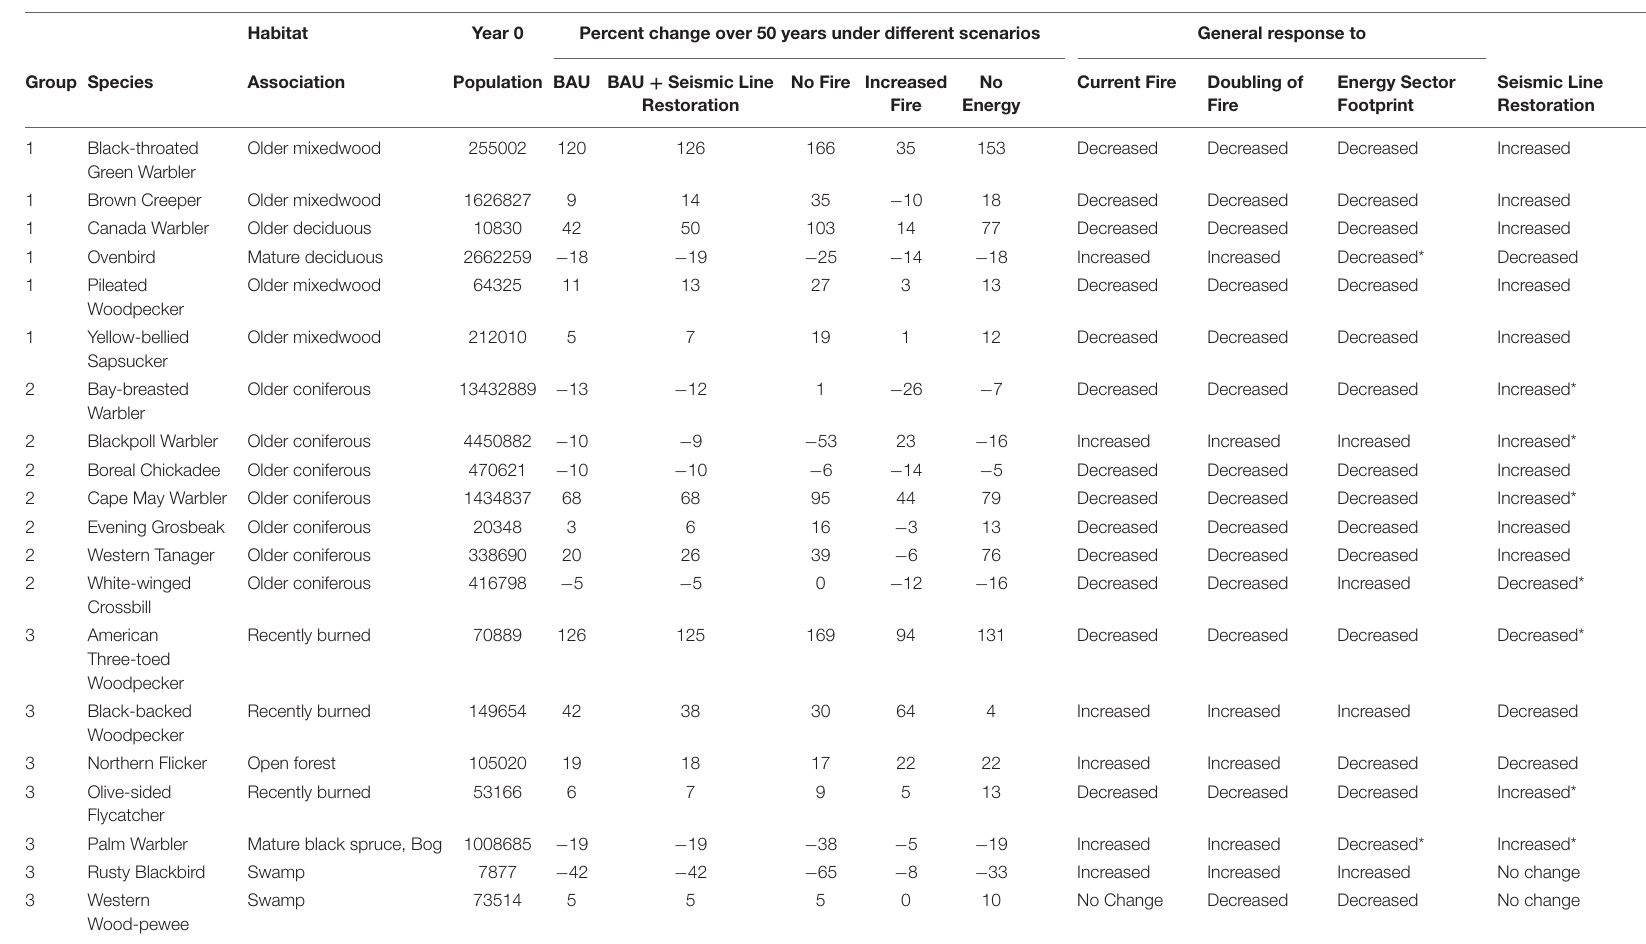
TABLE 3 | Initial population size and projected percent change in population of 20 species in the Al-Pac FMA over 50 years under 5 land use scenarios, along with projected response of each species to simulated current fire rates, doubled fire rates, energy sector development without seismic line restoration, and energy sector development with seismic line restoration. Habitat Year 0 Percent change over 50 years under different scenarios General response